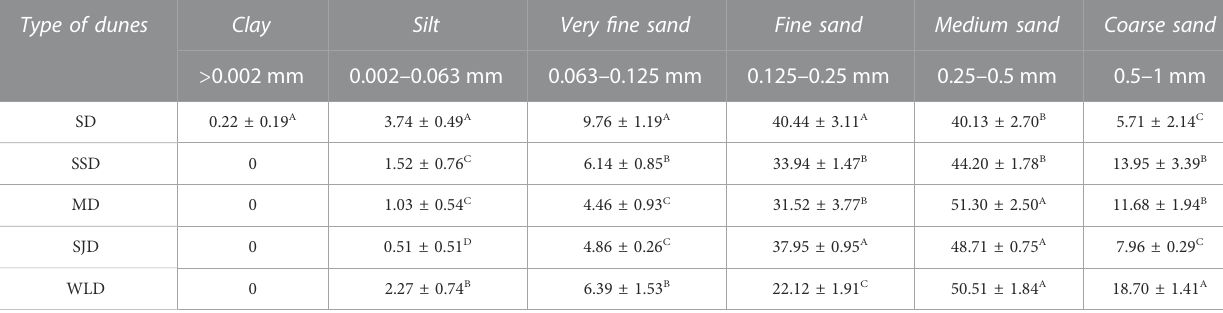
TABLE 6 Particle size composition (M±SE, %) in the surface 10 cm of deposits in different dunes. Type of dunes